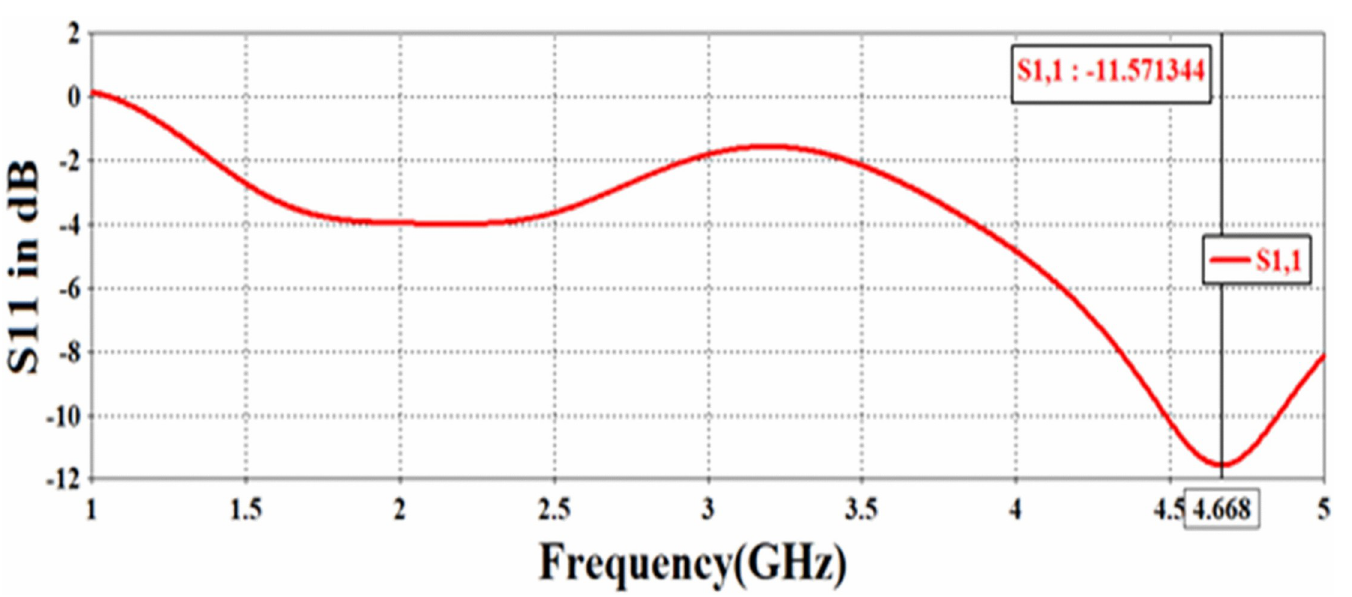
PLOS ONE | https://doi.org/10.1371/journal.pone.0232460 May 11,